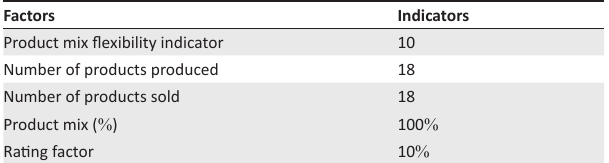
TABLE 15: Product mix flexibility.